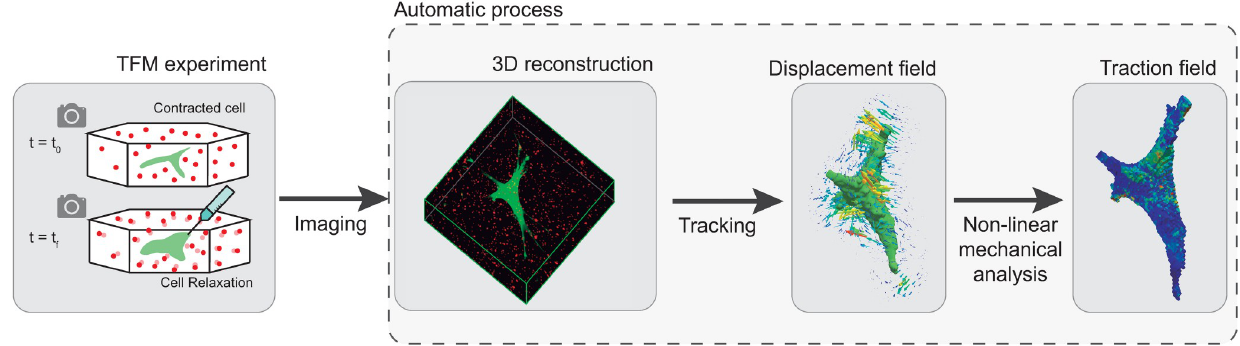
Fig 1. Workflow for 3D TFM and the developed numerical algorithm. Cellular tractions are obtained via a 3-step method. First, two pictures are captured during the experiment. Then, a 3D segmentation is obtained through the imaging process. The tracking method computes the displacement field and the cell geometry. Finally, the traction field is obtained via the resolution of the inverse